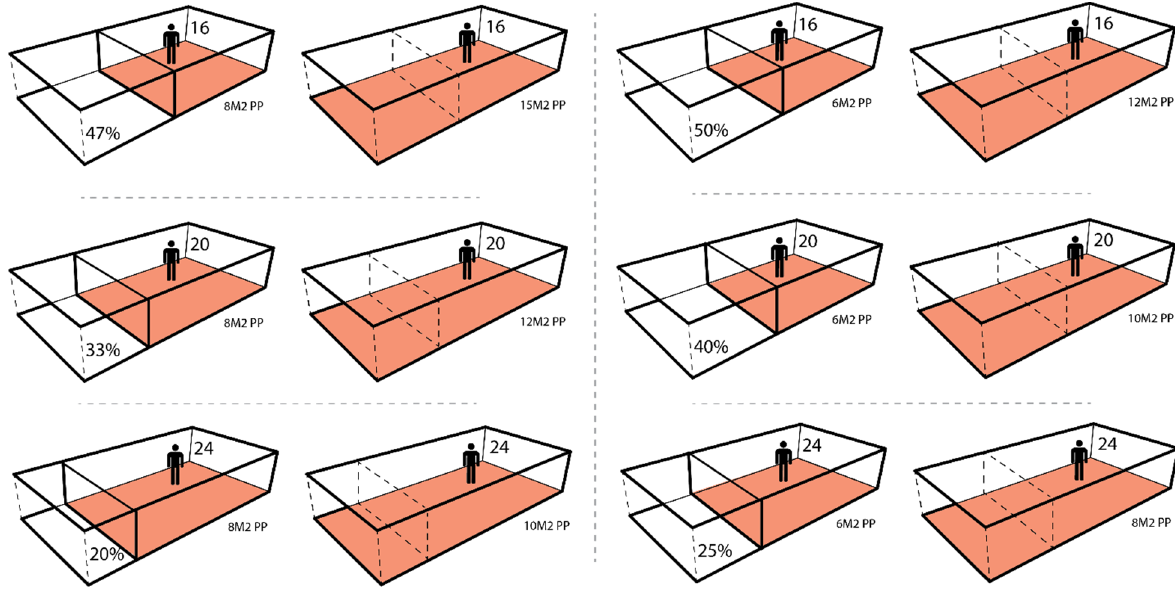
Figure 24. Diagrammatic representation of different relationships between internal and external areas as working areas in one typical rectangular floor plan, varying between 6 and 10 m 2 per person and discounting the space given to the external area (intermediate space), which varies from zero to 40% of the total office area.